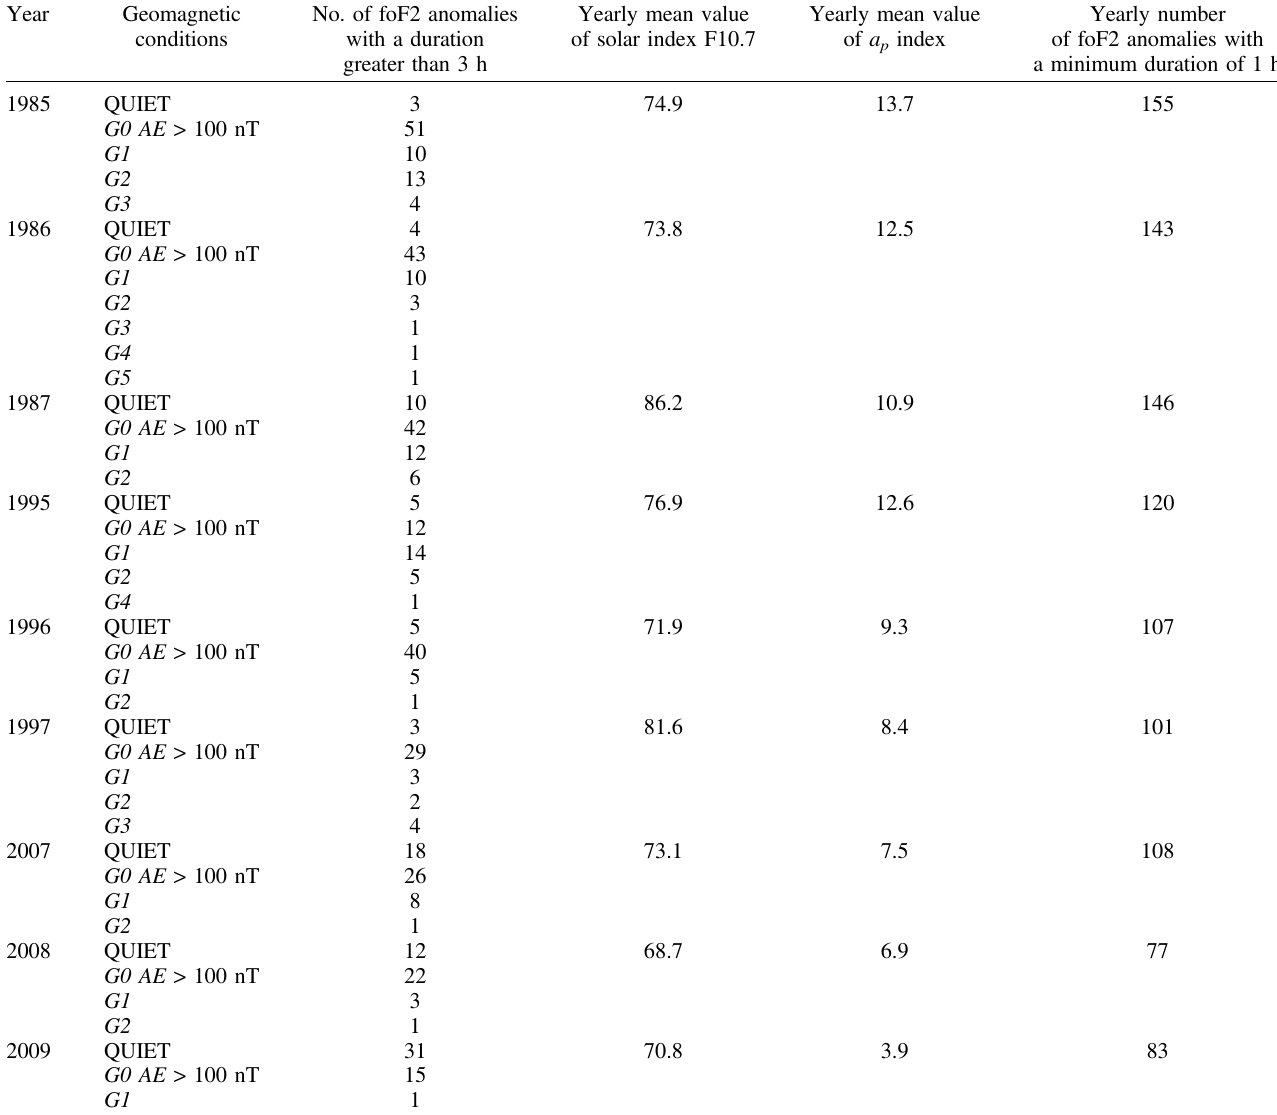
Table 1. Number of foF2 anomalies, with duration greater than 3 h, classi fi ed with respect to the corresponding geomagnetic activity level, together with the yearly values of the F10.7 solar index, the a p geomagnetic index and the number of foF2 anomalies with a minimum duration of 1